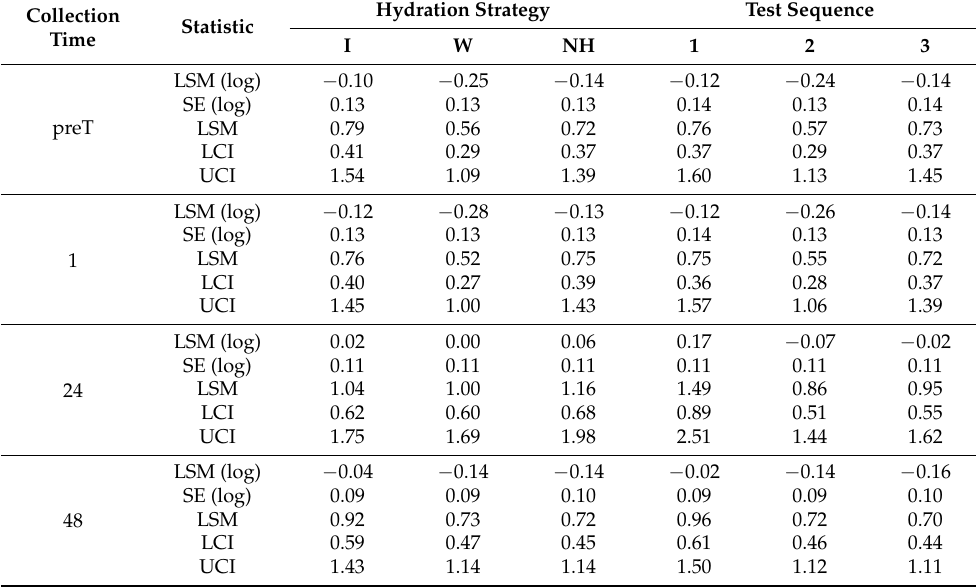
Table 19. Results for CRP [mg · mL − 1 ] measured before the test (preT) and 1, 24, and 48 h after the test performed for different hydration strategies in three consecutive tests: marginal means (LSM); standard errors (SE) for values after logarithmic transformation (log); and marginal means and upper (UCI) and lower (LCI) confidence intervals restored to original